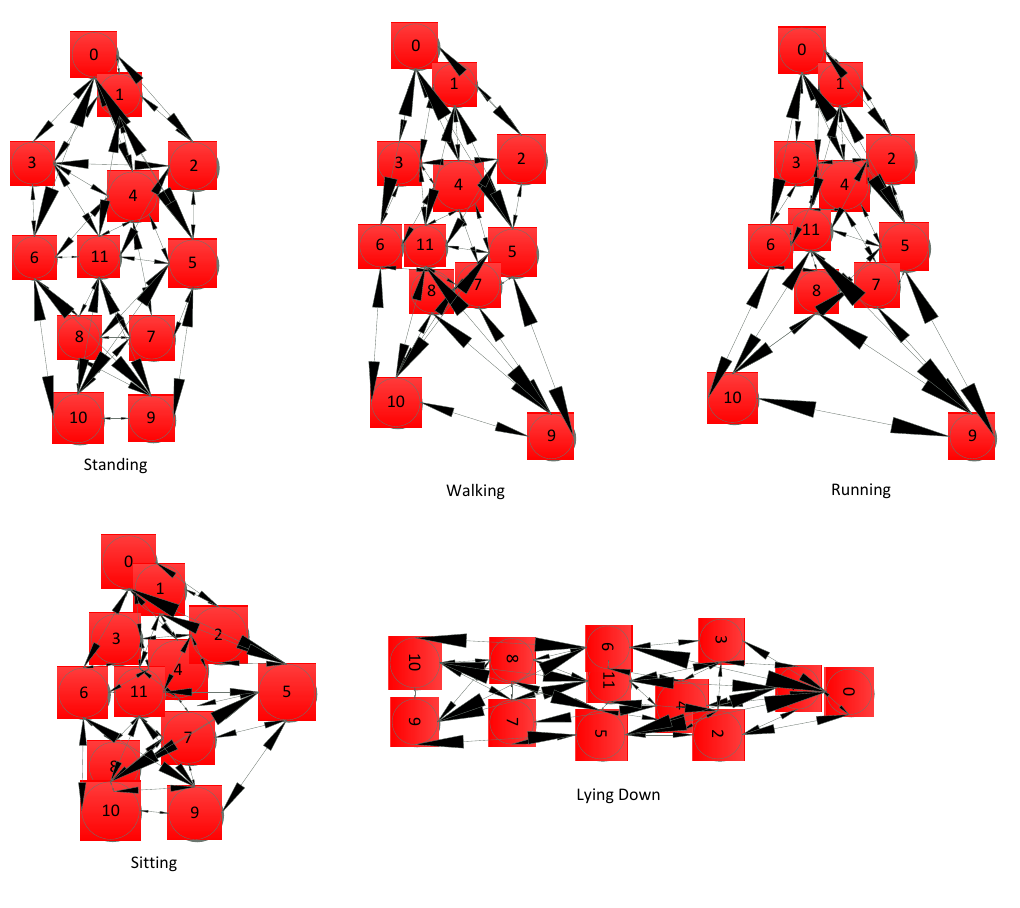
Figure 3. Posture orientations in